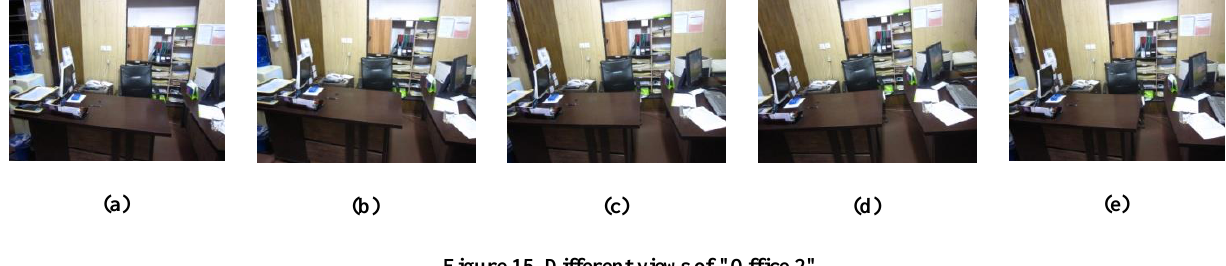
Figure 15. Different views of "Office